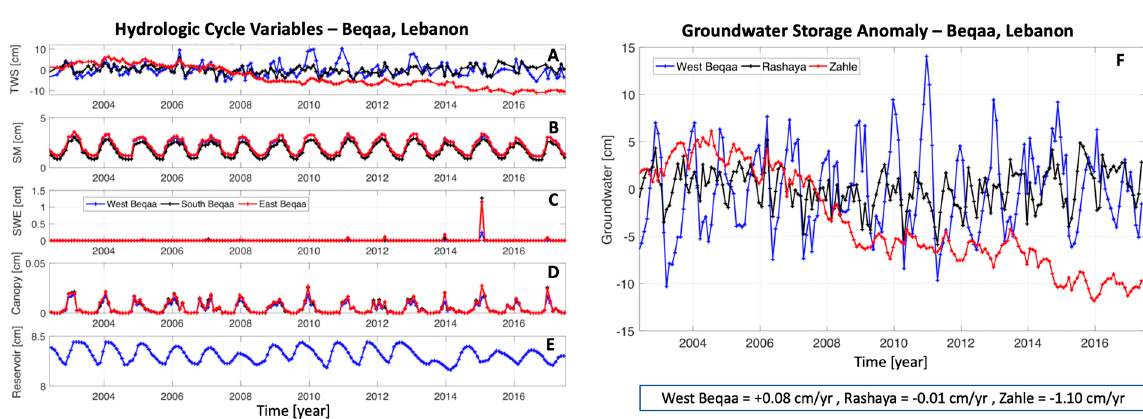
Figure 7. ( A–E ) Hydrologic variables for the three regions in this study. All units are converted to cm in order to calculate groundwater anomalies from the GRACE signal. ( F ) Groundwater storage anomalies, calculated for the three regions in this study. The rate of loss (cm/year) for each region is noted on the bottom of the figure.